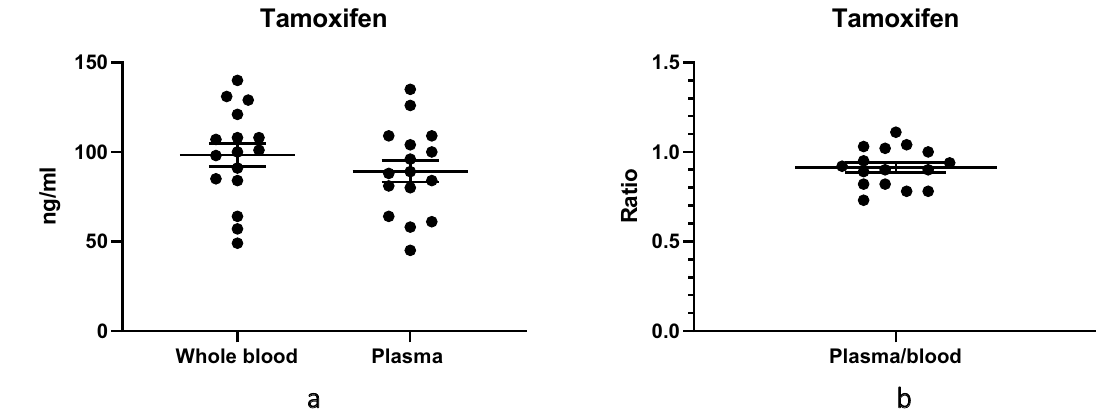
Figure 1. Tamoxifen (TAM) concentrations in 16 participants with breast cancer taking tamoxifen 20 mg daily: ( a ) Distribution of TAM concentrations in whole venous blood and in plasma. The means were not significantly different ( P = 0.325); ( b ) Distribution of ratios of plasma to venous blood TAM concentrations. In both graphs, the longer horizontal lines represent means (of concentrations or ratios), and the shorter horizontal lines represent standards of the mean (SEM).